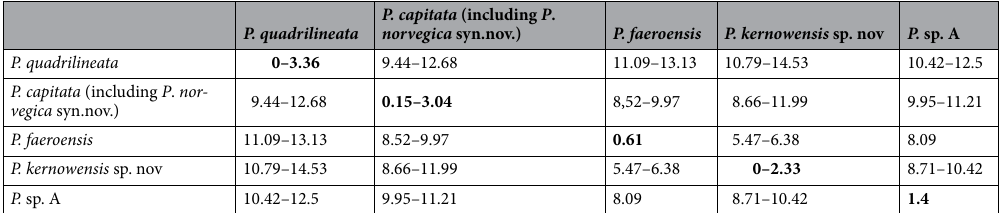
Table 2. Intragroup (highlighted in bold) and Intergroup genetic distances (%) for COI in the European Polycera species